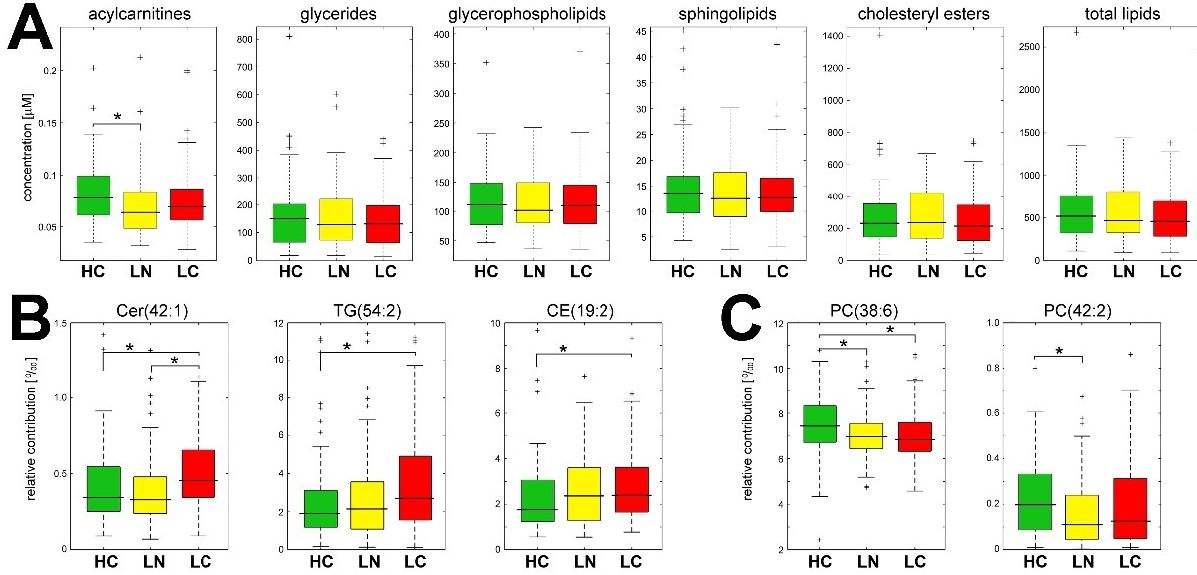
Figure 3. Level of lipids in serum-derived sEV. ( A ) Aggregated concentration of lipids from major classes in sEV samples; ( B ) relative contribution of selected lipids that were upregulated or ( C ) downregulated in the sEV of lung cancer patients. HC—healthy controls; LN—benign lung nodules; LC—lung cancer. Box plots show the median, minimum, maximum, lower, and upper quartile; crosses ( + ) represent outliers; asterisks (*) represent statistically significant differences between groups ( p < 0.05 in the pairwise post hoc test).